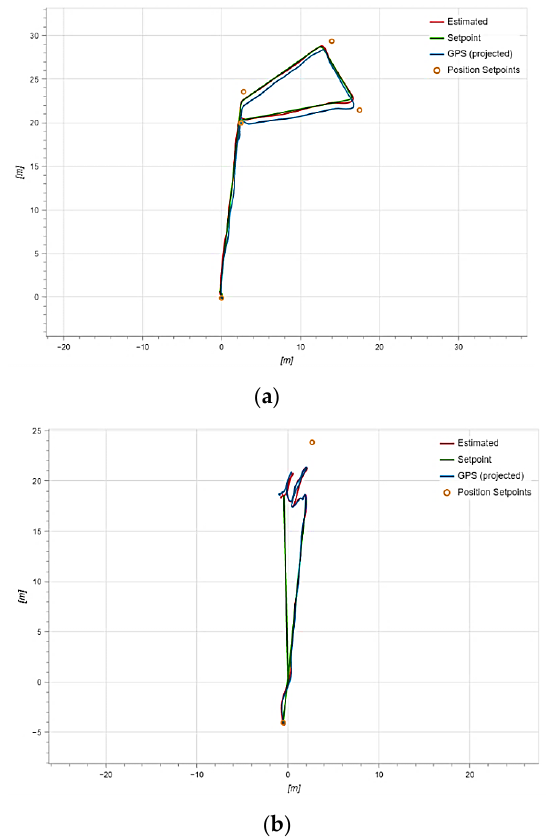
Figure 10. UAV flight trajectory during the mission: ( a ) under normal conditions and ( b ) under impact conditions.